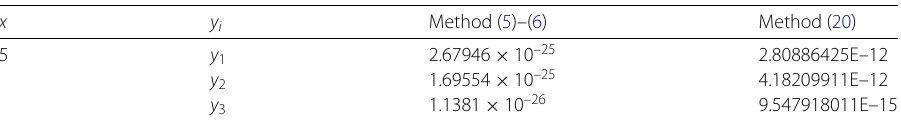
Table 3 The absolute errors for Test